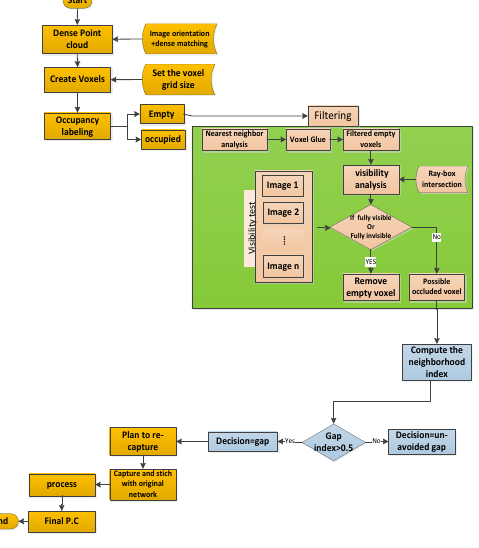
Figure 19. The opening in a point cloud can mislead the detection of gaps. (a) Viewing camera. (b) The image of the point cloud. (c) Occupied voxels. (d) Visibility analysis. (e) Gap detection (red voxels).